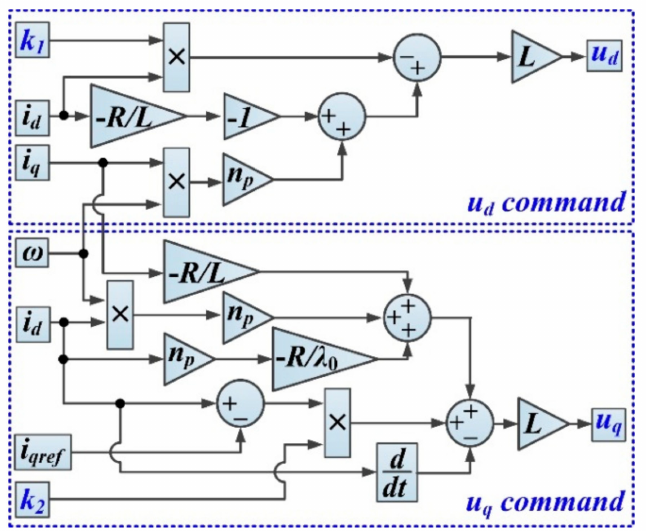
Figure 6. Schematic representation of a nonlinear-type controller: u d and u q